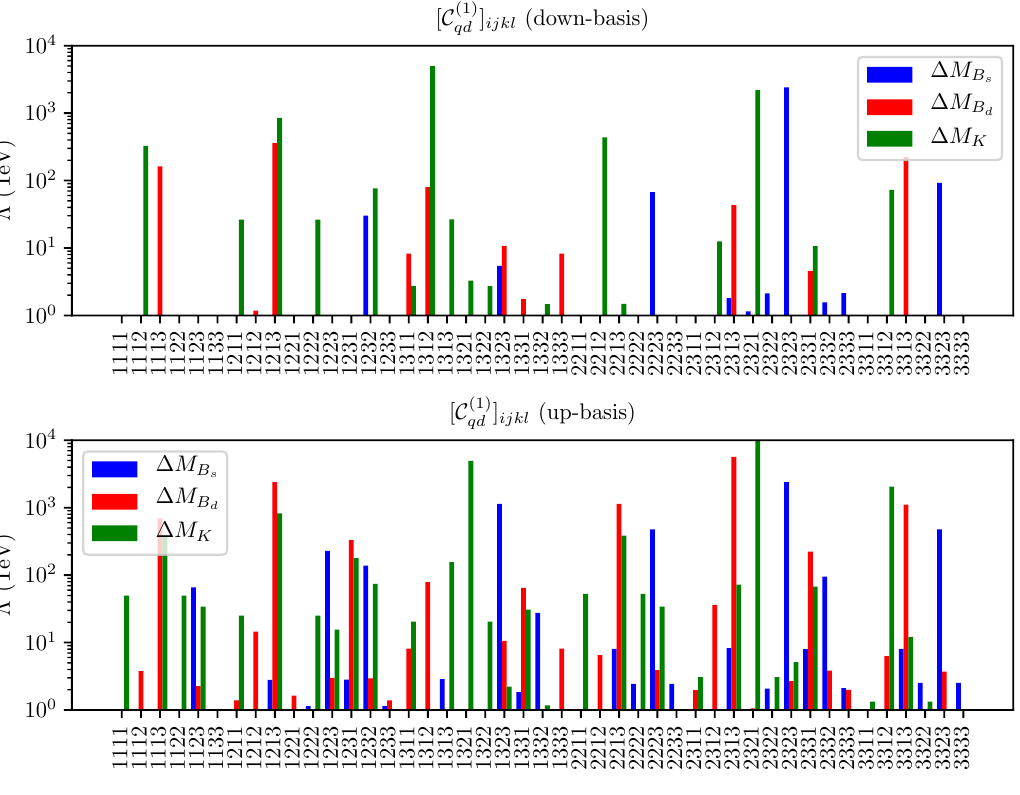
(cid:2) (cid:3) c (1) = 10 that corresponds to a 10% effect in qd ijkl